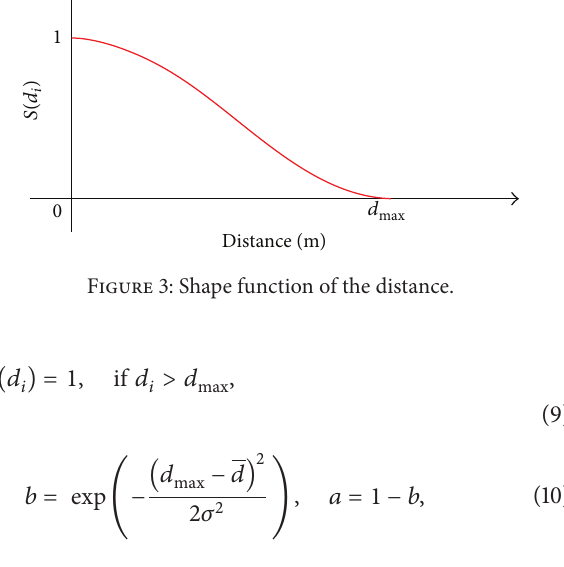
Figure 4; the objective of this arrangement is to investigate the effect of the walls to the robot in order to confirm the stability of the robot